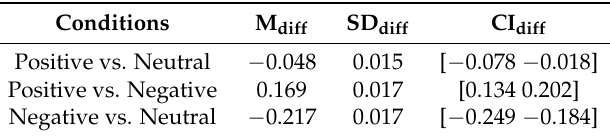
Figure A6. Paired two-sample bootstrap test of significance (10,000 simulation runs) at 95.0% confidence interval (CI) associated with the participants’ MSE20s (i.e., 62 MSE20s associated with 62 EEG channels of a participant, per affect). Compared pairs of mental states are: ( A ) positive versus neutral, ( B ) positive versus negative, and ( C ) negative versus neutral. X-axis: difference between average values of two affective states (e.g., positive versus negative). Blue line: non-significant difference between MSE20s of two different affective states. Red lines: 95.0% confidence interval boundaries. Yellow line: average two affetective states’ mean differences over 10,000 simulations. Table A6. Paired two-sample bootstrap test of significance (10,000 simulation runs) at 95.0% confidence interval (CI) applied on the participants’ MSE20 values (i.e., 62 MSE20s associated with 62 EEG channels of a participant, per affect). Compared pairs of mental states are: positive versus neutral, positive versus negative, and negative versus neutral. M: mean difference, SD: standard deviation of such a difference. CI: 95% confidence interval for every paired affective states’